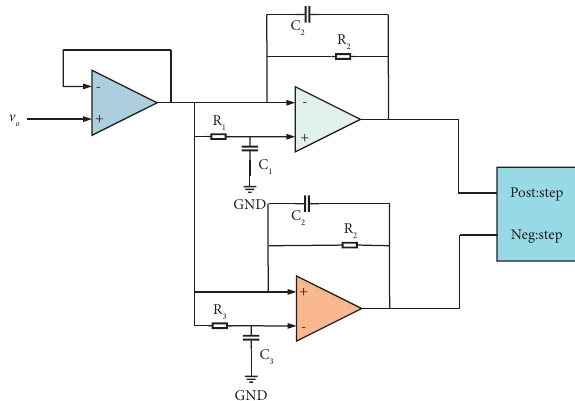
Figure 10: Implementation of the load change detector.